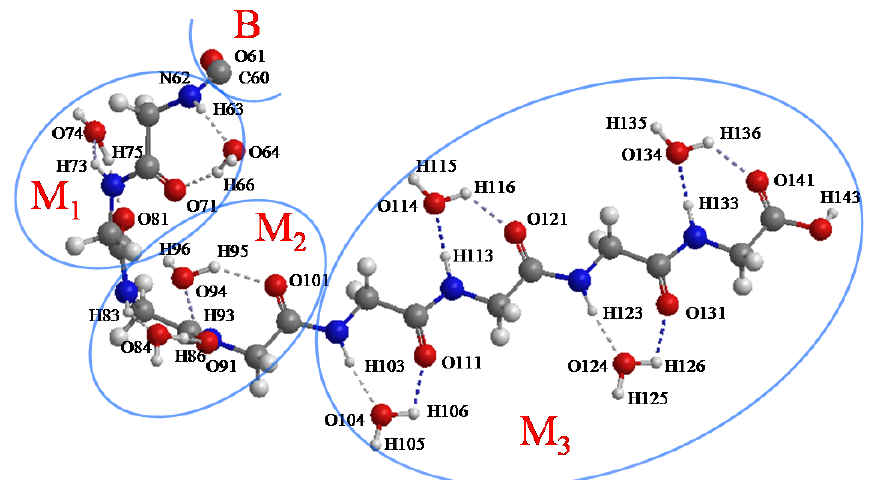
Figure 5. The initial structure of the M and O61 belong to the B region.